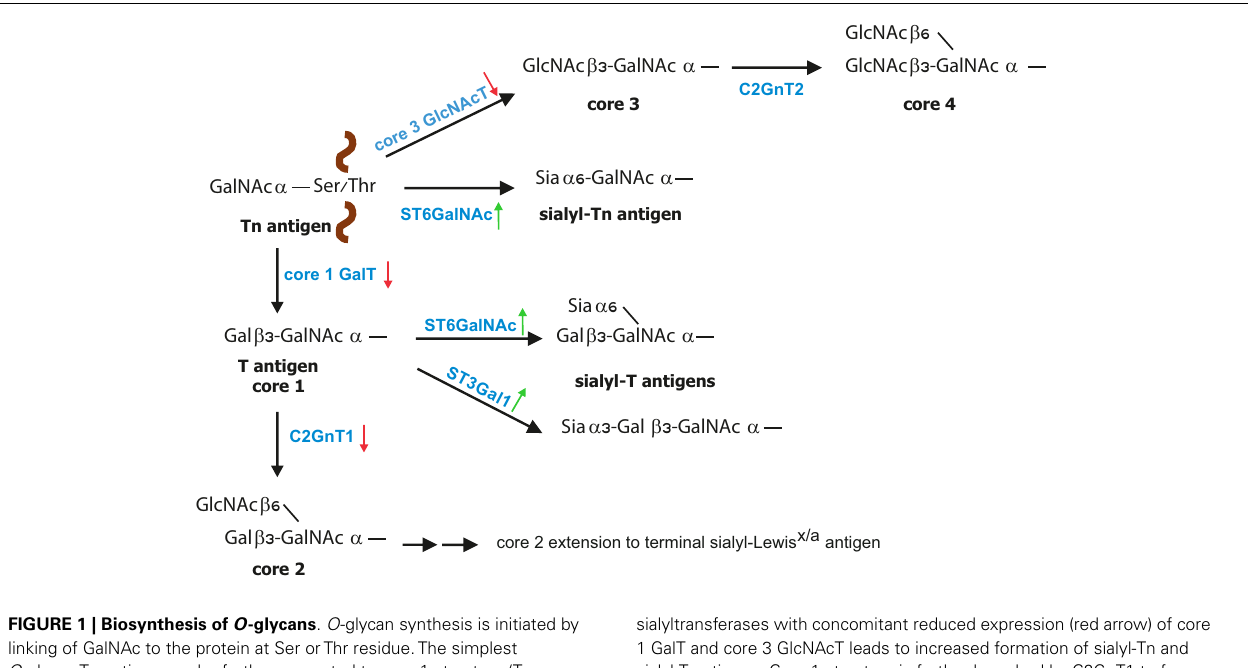
FIGURE 1 | Biosynthesis of O -glycans . O -glycan synthesis is initiated by linking of GalNAc to the protein at Ser orThr residue.The simplest O -glycanTn antigen can be further converted to core 1 structure (T antigen) by β 1,3 galactose extension; core 3 structure by addition of β 1,3-GlcNAc. During cancer increased expression (green arrow) of